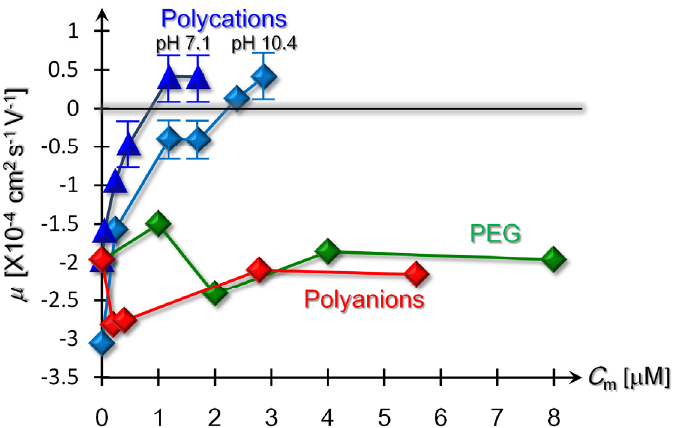
Figure 2. Changes of electrophoretic mobilities due to the addition of polycations (S-PLL) at pHs of 7.1 and 10.4, neutral polymers (PEG) and polyanions (L-NaPSS). Error bars lie within symbols if